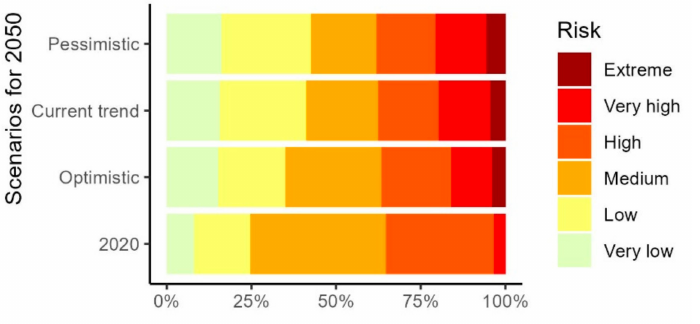
Figure 5. Proportion of existing hydropower projects in different risk classes for flood risk currently (2020) and in 2050 under three scenario pathways: optimistic, current trend, and pessimistic.